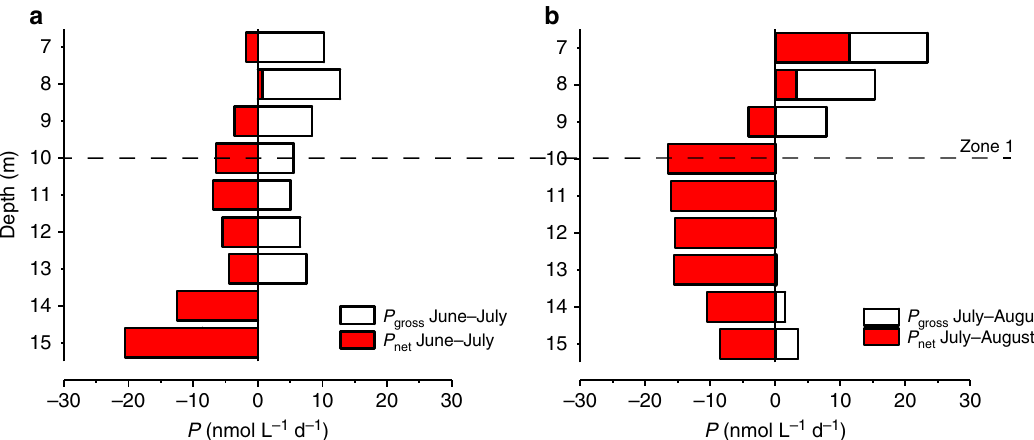
Fig. 6 High-resolution water column CH 4 production and consumption rates. System-wide CH 4 production rates (white bars, P gross,m ) obtained by Fick ’ s 2nd law and local production P net,m (red bars) = [ P gross,m − ( F L + F D )] for the period a June – July and b July – August 2016. P net,m rates indicate an overall net CH 4 production/consumption of − 0.3 ± 3.0 nmolL − 1 d − 1 in the metalimnion (zone 1; 6 – 10 m), while consumption rates increase up to − 20 nmol L − 1 d − 1 below 10 m. This analysis shows that a small net CH 4 production (red bars) is observed between 7 and 8 m between June and August 2016 (~5 ± 5 nmolL − 1 d − 1 ). Note that the depth integrated production starts between 6 and 7 m; above 6 m depth (SML) the vertical diffusion ( K z ) used in Fick ’ s 2nd law cannot be accurately inferred with the heat budget method (Methods). The dashed line indicates the lower limit of zone